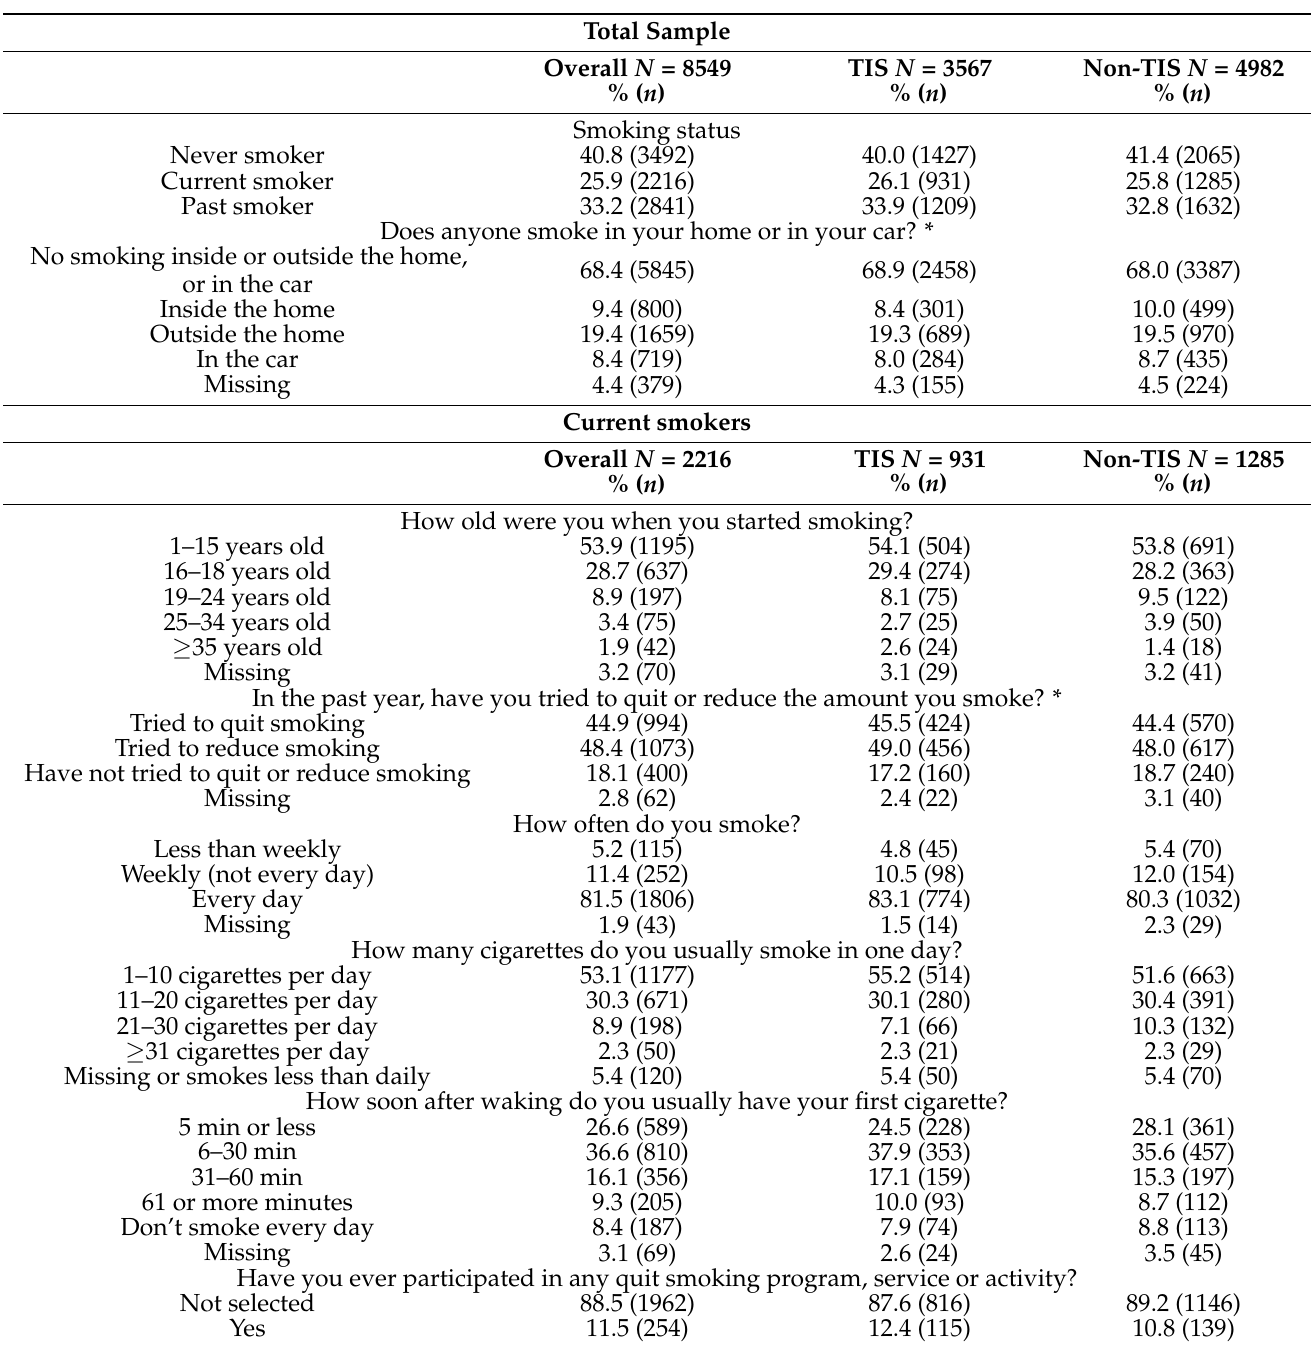
Table 4. Smoking-related behaviours in the total sample, current smokers, and past smokers, overall and by